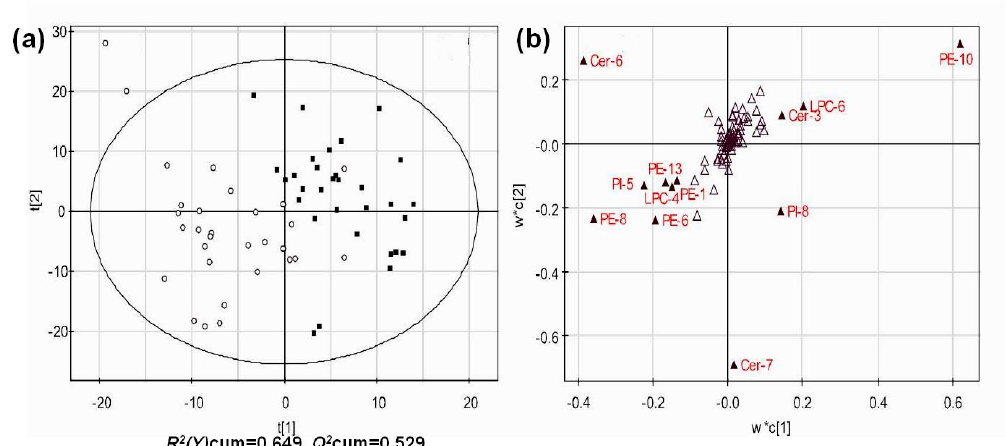
Figure 3. Multivariate analysis of lipid profile. The partial least squares-discriminate analysis (PLS-DA) score ( a ) and loading ( b ) plots were obtained based on the profiles of different lipid classes in sera from different people of SLE ( N = 30, open circles) and normal ( N = 30, solid squares). Figure 3b shows the variable importance of the projection (VIP) plot, indicting which variables are important in explaining both the X- and Y-data. The solid triangles (VIP value > 1.0) in Figure 3b are important contributors to the model. The detailed information about abbreviation of lipid species is shown in Table